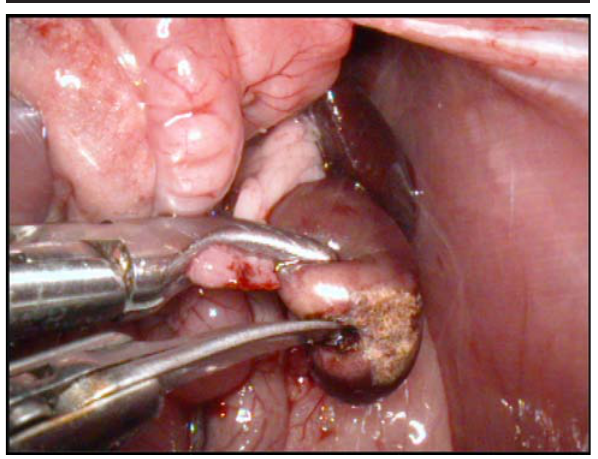
FIGURE 3 - Section of renal inferior pole